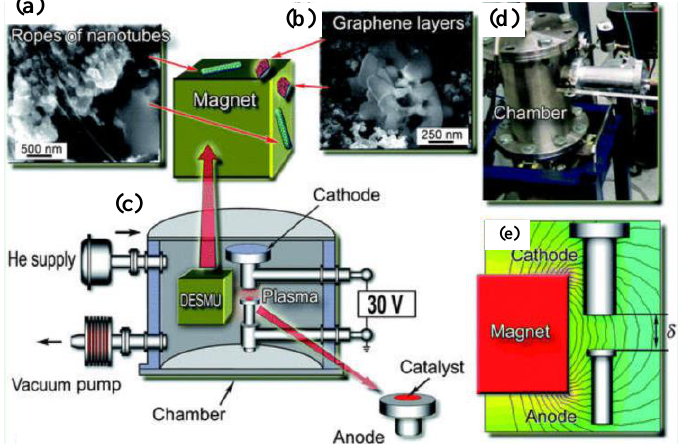
Figure 12. Schematic diagram of arc plasma method in the magnetic field. ( a ) Carbon nanotubes; ( b ) Graphene; ( c ) Experimental structure; ( d ) Real equipment; ( e ) Local image. (Reproduced from [77] with permission; Copyright 2010 The Royal Society of Chemistry.)